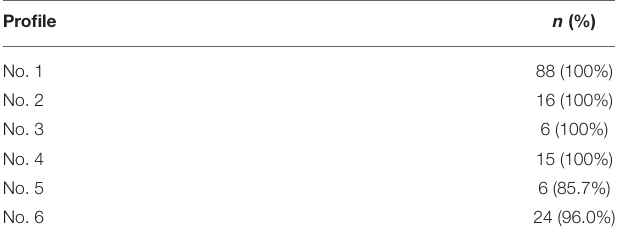
TABLE 3 | Values of fit indices for solutions with different numbers of profiles. TABLE 4 | Number of participants in stable relationships depending on the profile of perceived support.